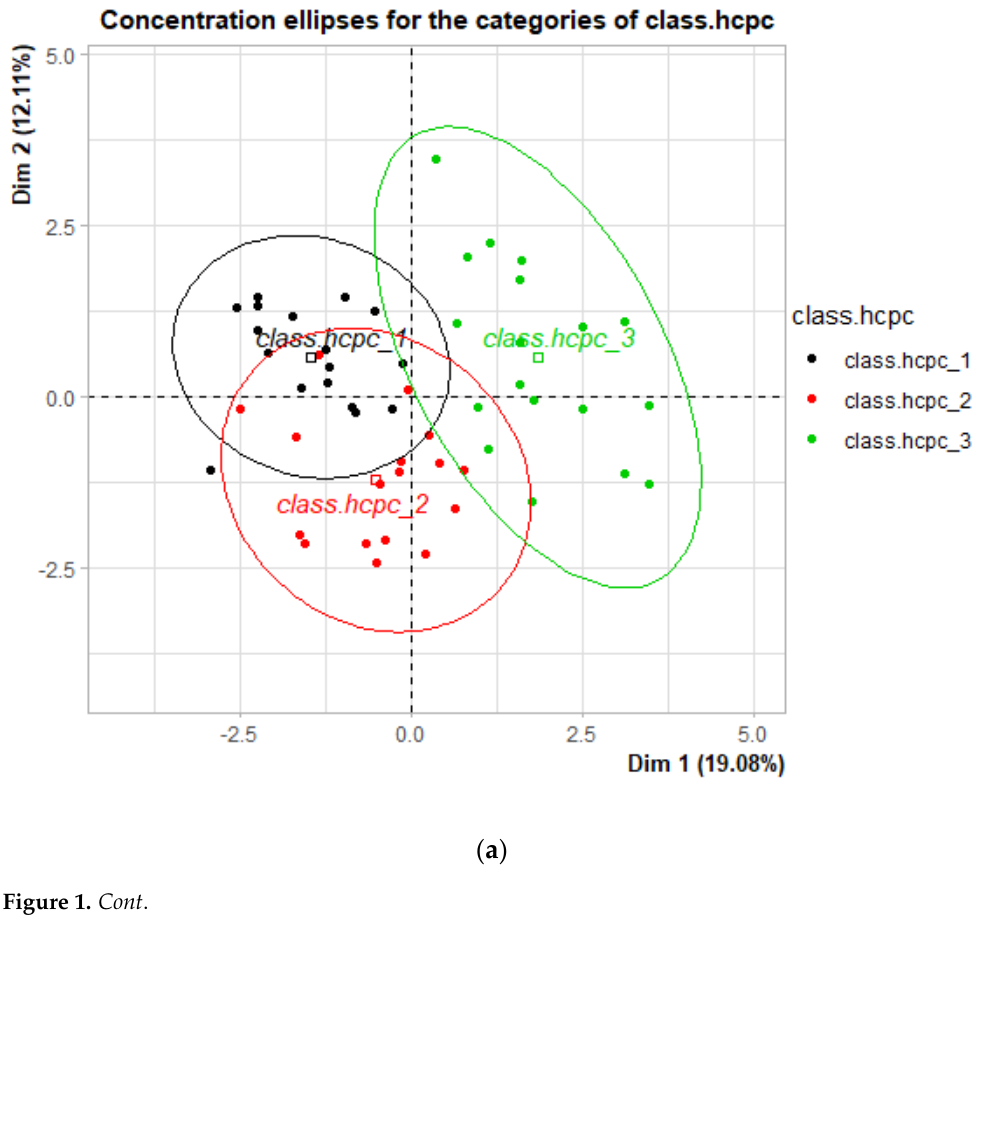
Table 3. Eigenvalues obtained from multiple factor analysis and percentages of variance explained.